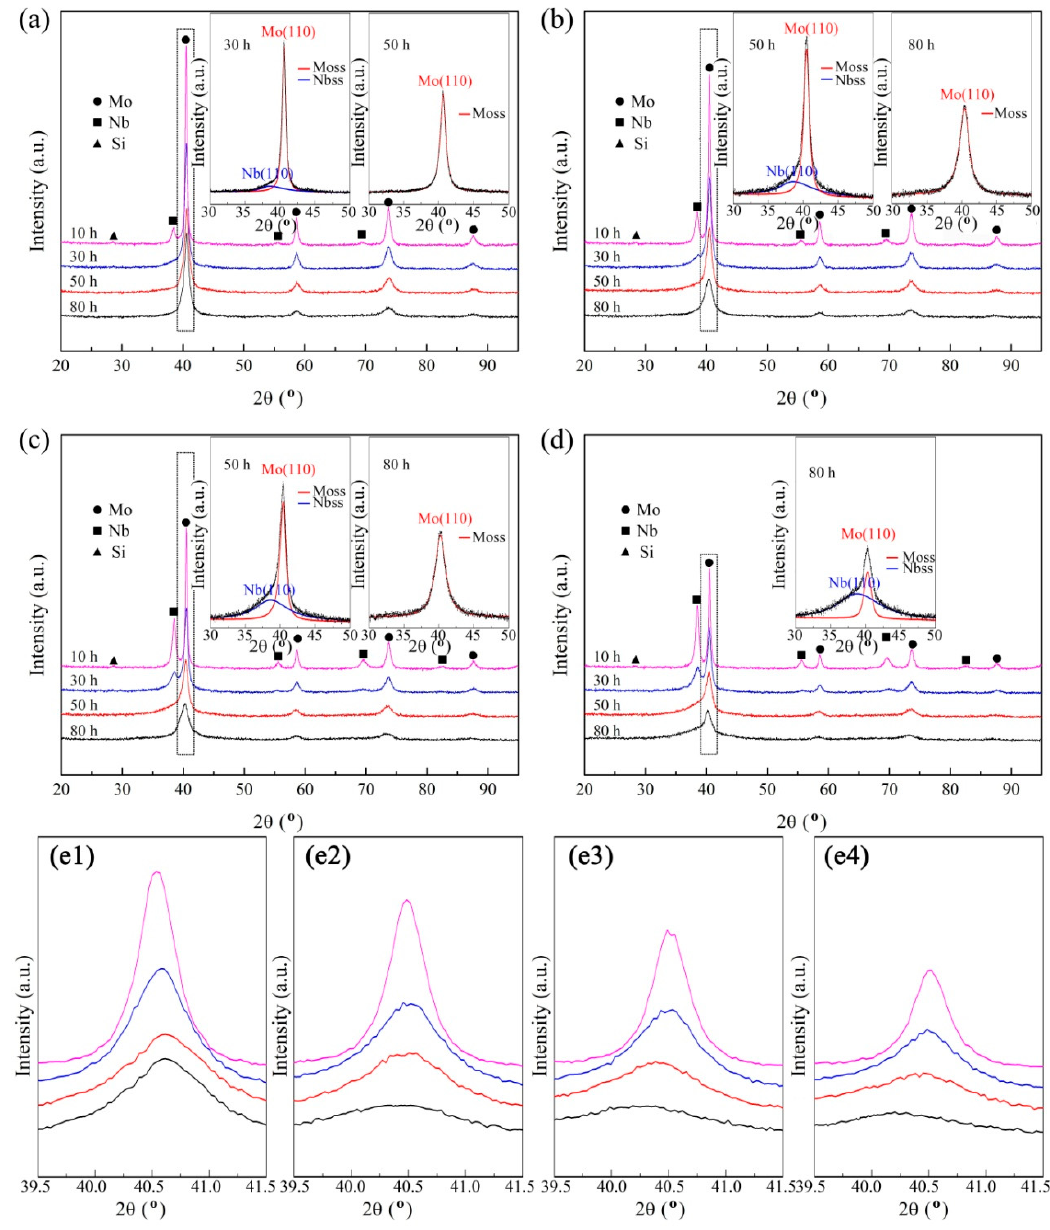
Figure 3. XRD spectra of powders with ( a ) 10, ( b ) 20, ( c ) 30, and ( d ) 40 at.% Nb contents after different milling time. Insets: deconvolution calculation results in 2 θ range from 30 to 50 degree. ( e 1), ( e 2), ( e 3) and ( e 4) are the enlarged views for (a), (b), (c), and (d), respectively, in the 2 θ range from 39.5° to 41.5° containing Mo(110) peaks.